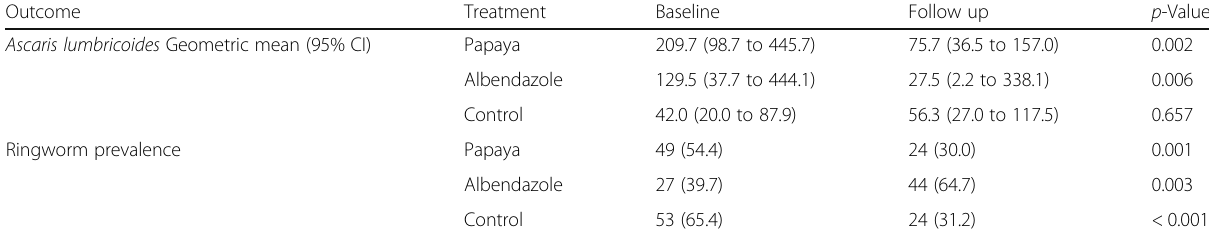
Table 3 Ascaris lumbricoides egg counts and ringworm prevalence at baseline and 8 weeks after treatment per treatment group Outcome Treatment Baseline